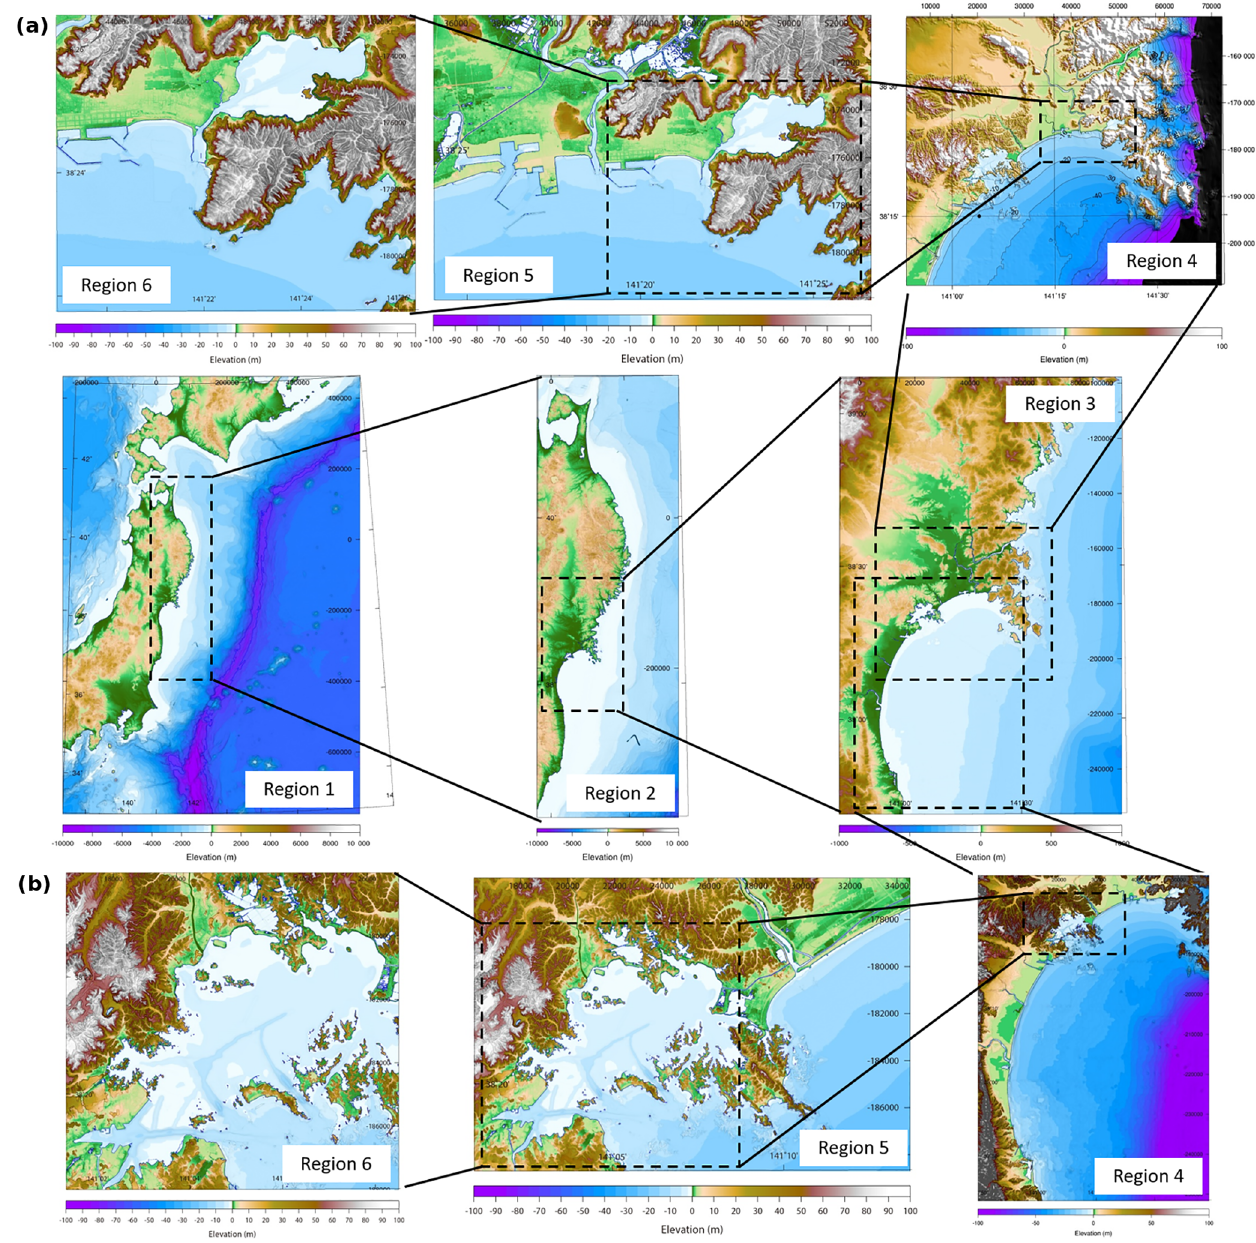
Figure 3. Six computational areas for (a) Mangokuura Lake and (b) Matsushima Bay. Table 1. Aida’s K and κ for each model and after the model